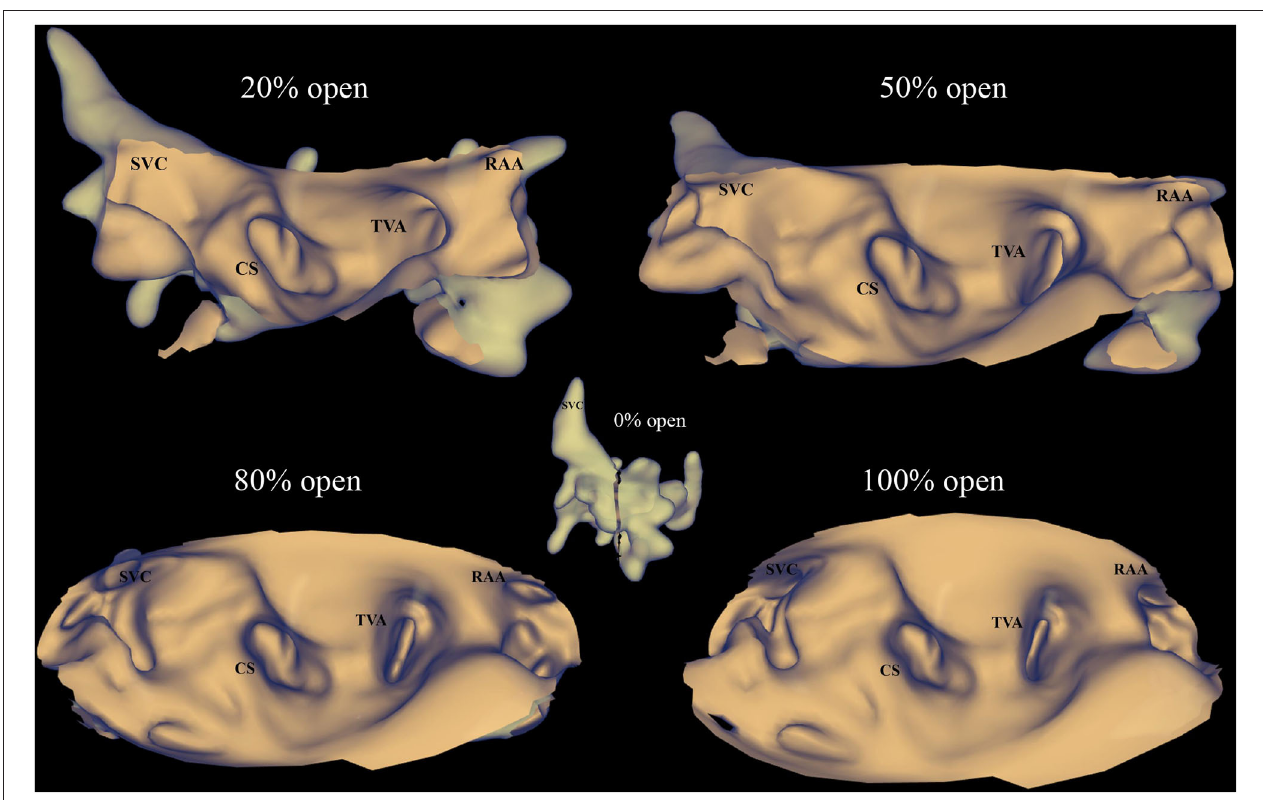
FIGURE 6 | PANO view of the KODEX-EPD system. The anatomical image in the KODEX system can be displayed as a novel panoramic (PANO) view, which transforms the 3D cardiac structure into a virtual two-dimensional (2D) panoramic picture. This view allows all the anatomically relevant structures to be seen in one view. The percentage of open (0% open to 100% open) represents the degree of transformation from a 3D image to a flattened image, 0% open means the image is still shown as a 3D cardiac structure, while 100% open means the full unfolding of the 3D cardiac structure. CS, coronary sinus; RAA, right atrial appendage; SVC, superior vena cava; TVA, tricuspid valve